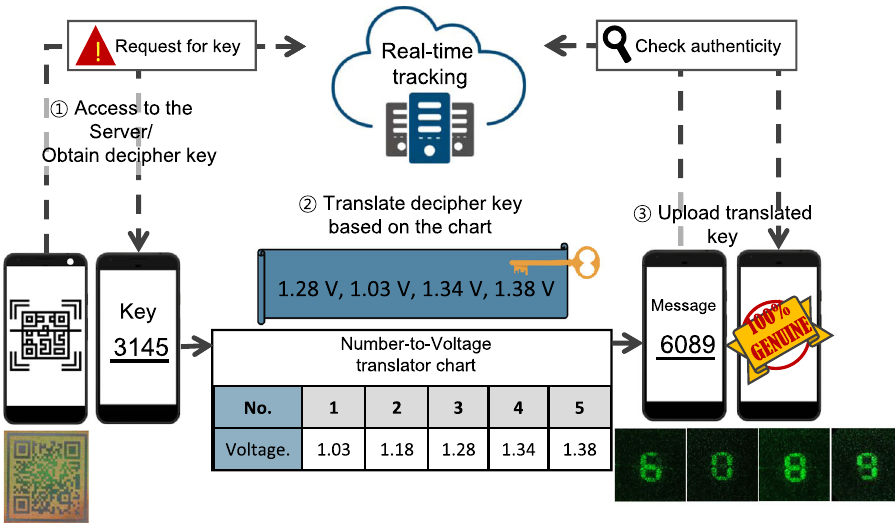
Fig. 5 Vectorial holographic color prints based two-level security platform. Firstly, a user who wants to unlock the system should scan the smart label exhibiting re fl ection image of two-colored QR code using smart phone or relevant scanners. Such access information is real-time tracked at the main server and the fi rst key will be distributed. Secondly, the fi rst key will be translated to inform the user of the voltage value which will be applied on our LC- integrated device. Then, automatically the smart label will produce holographic images in a space, which is the second key to unlock the system. At the same time, such access will also be transmitted into the main server to fi nally check the authenticity (See Supplementary Video